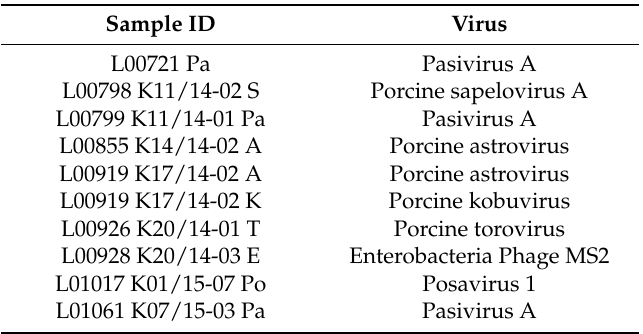
Table 2. Complete coding sequences of viruses discovered as coinfection in feces from PEDV infected